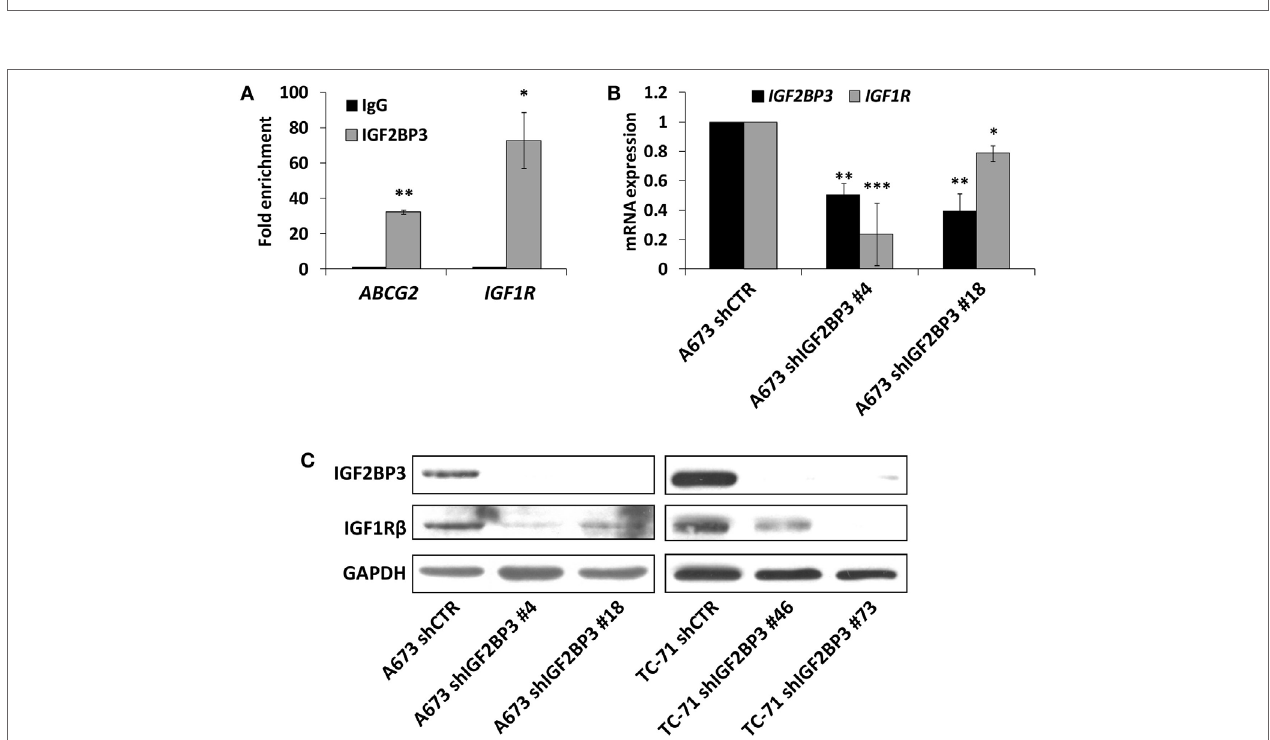
FigUre 2 | Assessment of IGF1R as an insulin-like growth factor 2 mRNA-binding protein 3 (IGF2BP3) mRNA target in Ewing sarcoma (ES) cells. (a) Quantitative real-time PCR analysis of IGF2BP3-associated mRNAs isolated from the cytoplasmic extracts of A673 cells by immunoprecipitation using an anti-IGF2BP3 antibody. Non-immune goat IgG was used as a negative control. ABCG2 was used as positive control. Columns represent the mean values of two independent experiments, in which samples were run in triplicates, and the bars represent the SE. * p < 0.05, ** p < 0.01, Student’s t -test. (B) mRNA expression levels of IGF2BP3 and IGF1R in IGF2BP3-depleted or empty vector-transfected (shCTR) A673 ES cells. GAPDH was used as a housekeeping gene. Columns represent the mean values of at least two independent experiments, in which samples were run in triplicates, and the bars represent the SE. * p < 0.05, ** p < 0.01, *** p < 0.001, one-way ANOVA with respect to shCTR. (c) Western blotting showing IGF2BP3 and IGF1R expression in IGF2BP3-depleted or empty vector-transfected (shCTR) A673 (left) or TC-71 (right) ES cells. GAPDH was used for normalization. Data from one experiment representative of three.